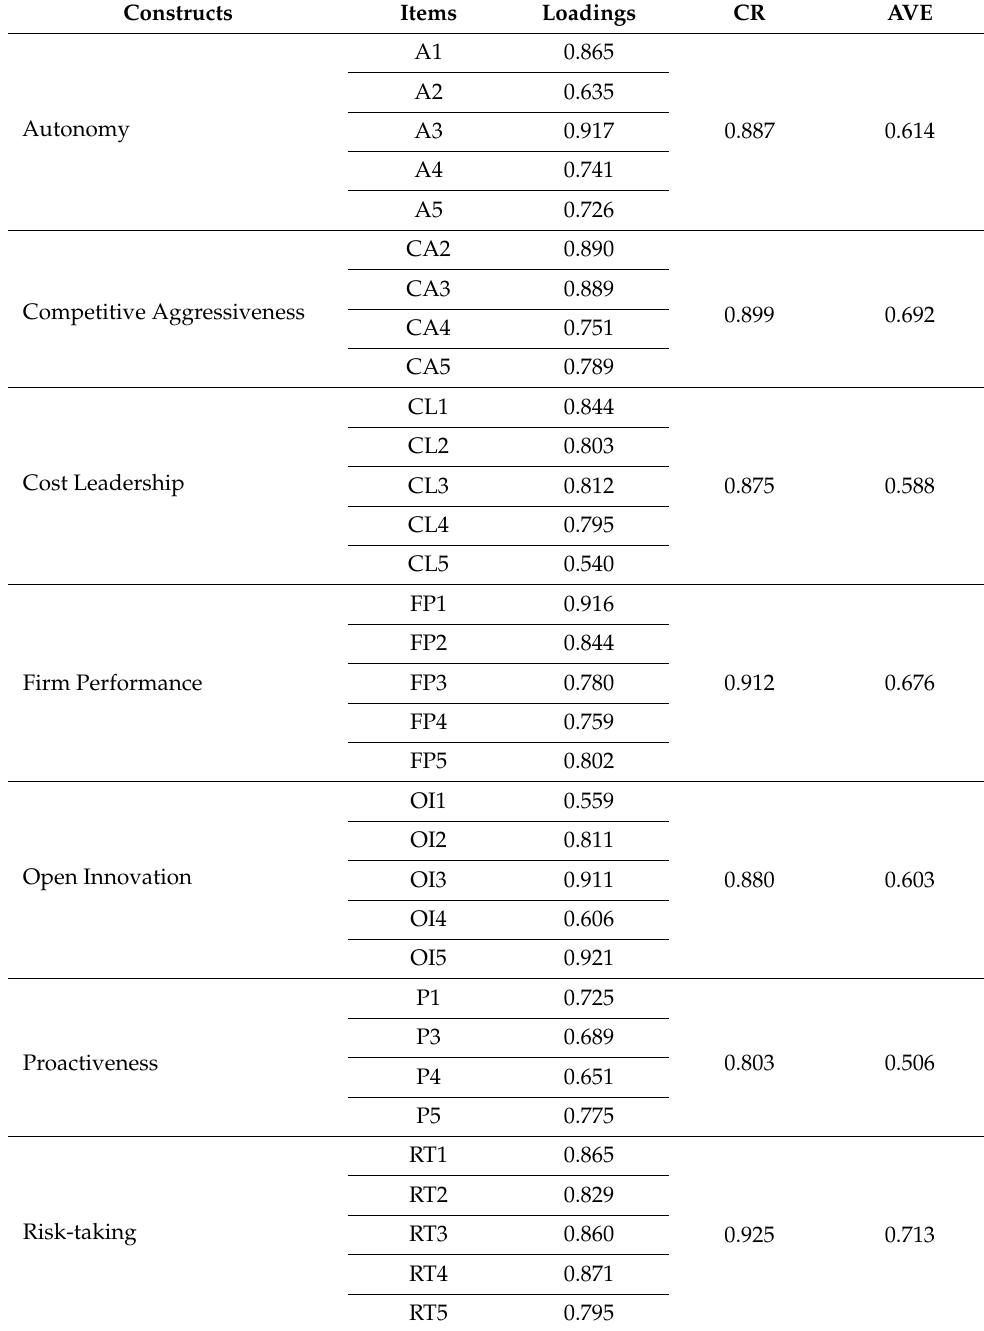
Table 3. Assessment of measurement